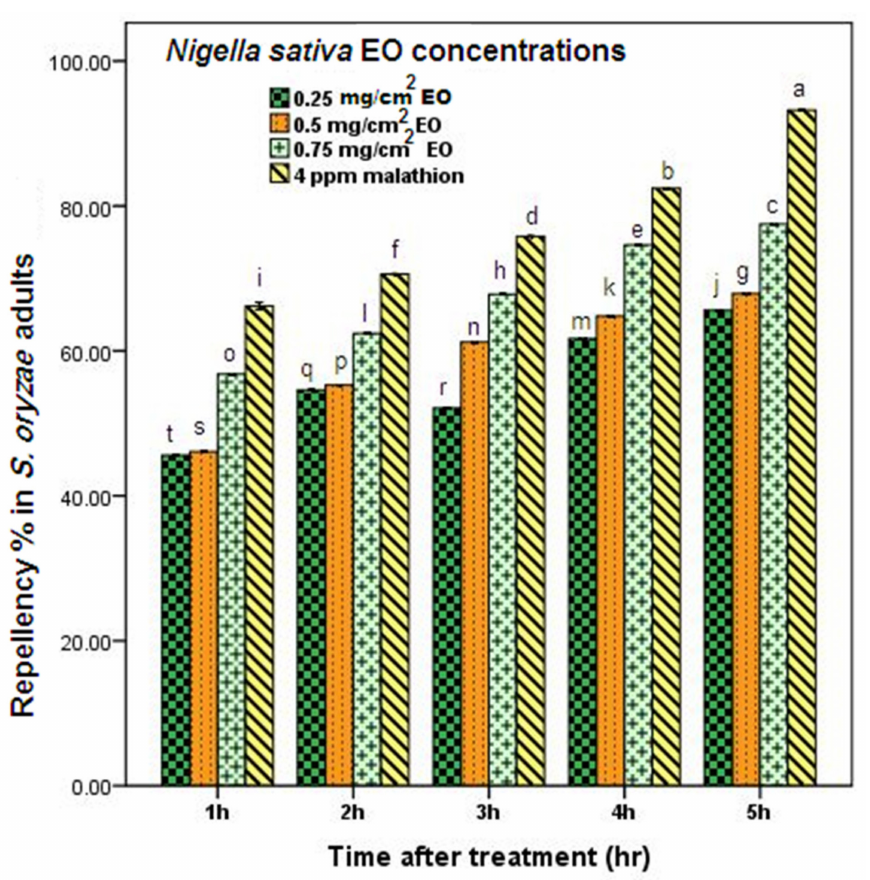
Figure 5. Impact of different concentrations (0.25, 0.5, and 0.75 mg/cm 2 ) from N. sativa EOs on repellent % of S. oryzae adults at 1, 2, 3, 4, and 5 h exposure times (mean ± SD) compared with standard chemical pesticide (4 ppm malathion). Different letters indicate significant differences between different treatments at p < 0.05; LSD =